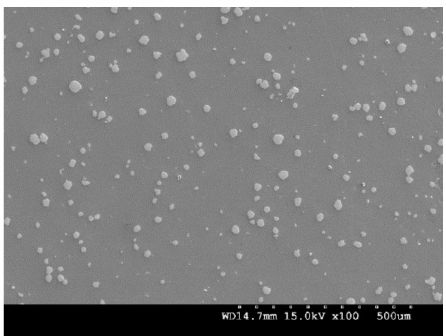
Figure 12. Scanning electron micrograph showing uniform distribution of Ni 60 Nb 40 (atomic pct.) amorphous alloy reinforcement in pure magnesium matrix, synthesized by bi-directional microwave sintering.